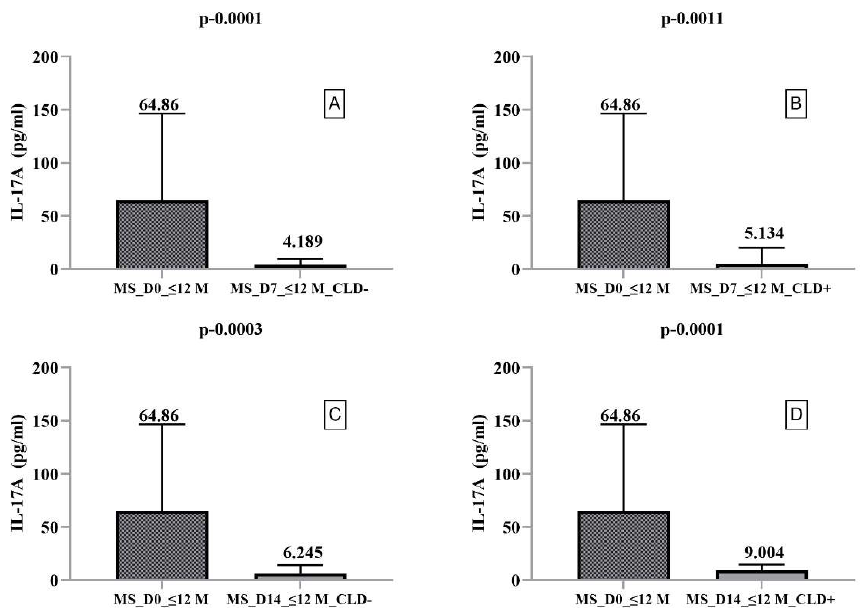
Figure 2. Boxplot type diagrams through which we followed the medians and interquartile range. Median values and statistical significance are mentioned in the graph. Comparison of CLD exposure